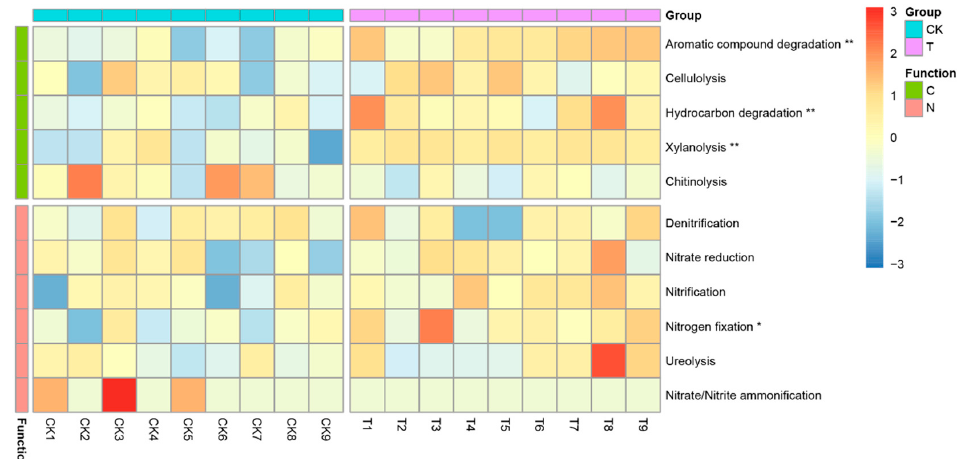
Figure 6. Heatmap of the potential functional groups of rhizosphere bacteria communities. T and the color purple represent Streptomyces treatment; CK and the color blue represent the control without Streptomyces . C and the color green represent bacteria abundance associated with the carbon cycling function; N and the color green represent bacteria abundance associated with the nitrogen cycling function. * p < 0.05; ** p <